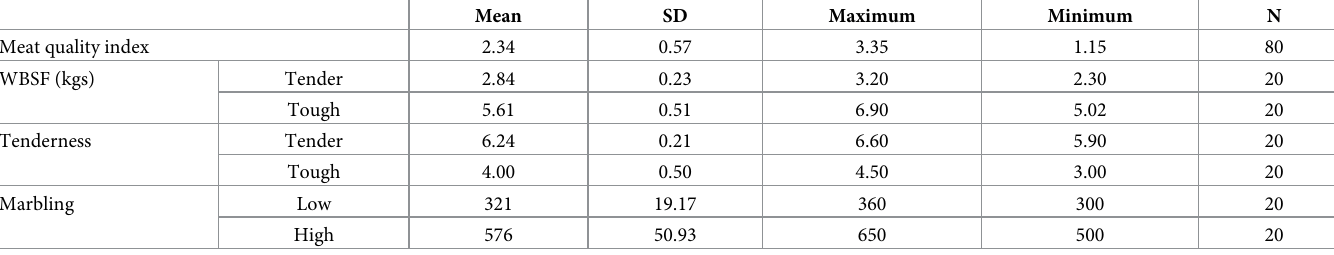
Table 1. Descriptive statistics for the meat quality phenotypes and the constructed meat quality index.